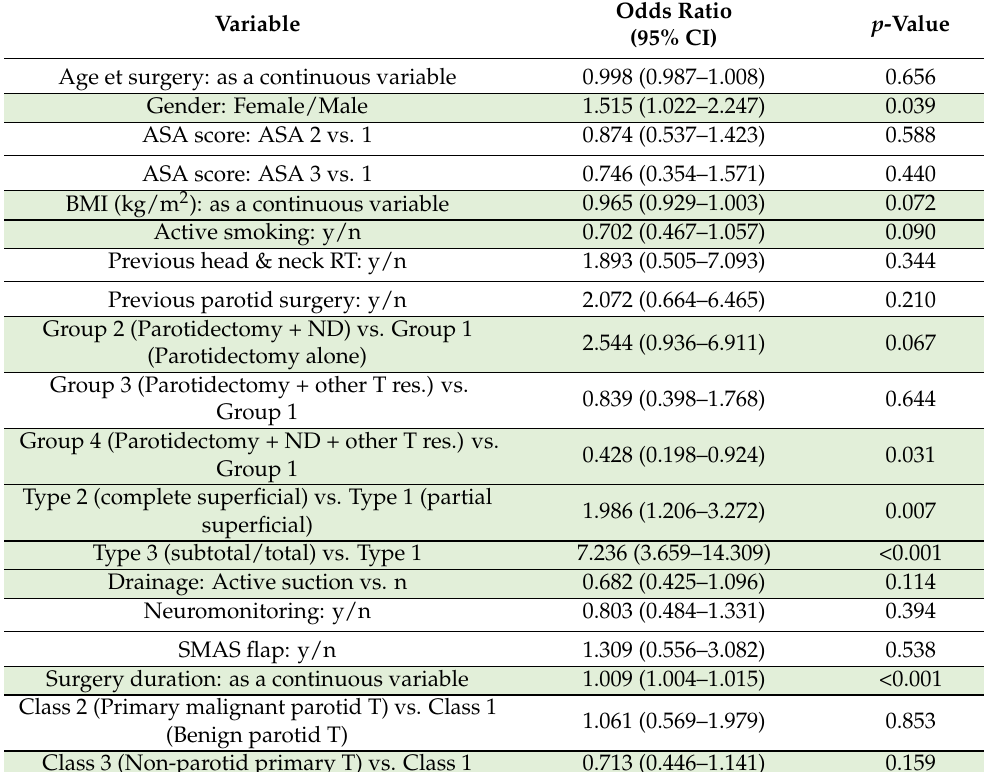
Table 7. Univariate logistic regression with selected variables for occurrence of facial paralysis as perioperative complication (surgical procedures: n = 428). Variables with a p -value < 0.2 selected for multivariate logistic analysis are in colored lines. Abbreviations: y: yes, n: no, ASA: American Society of Anesthesiologists, BMI: Body Mass Index, RT: radiotherapy, T: tumor, res.: resection, ND: